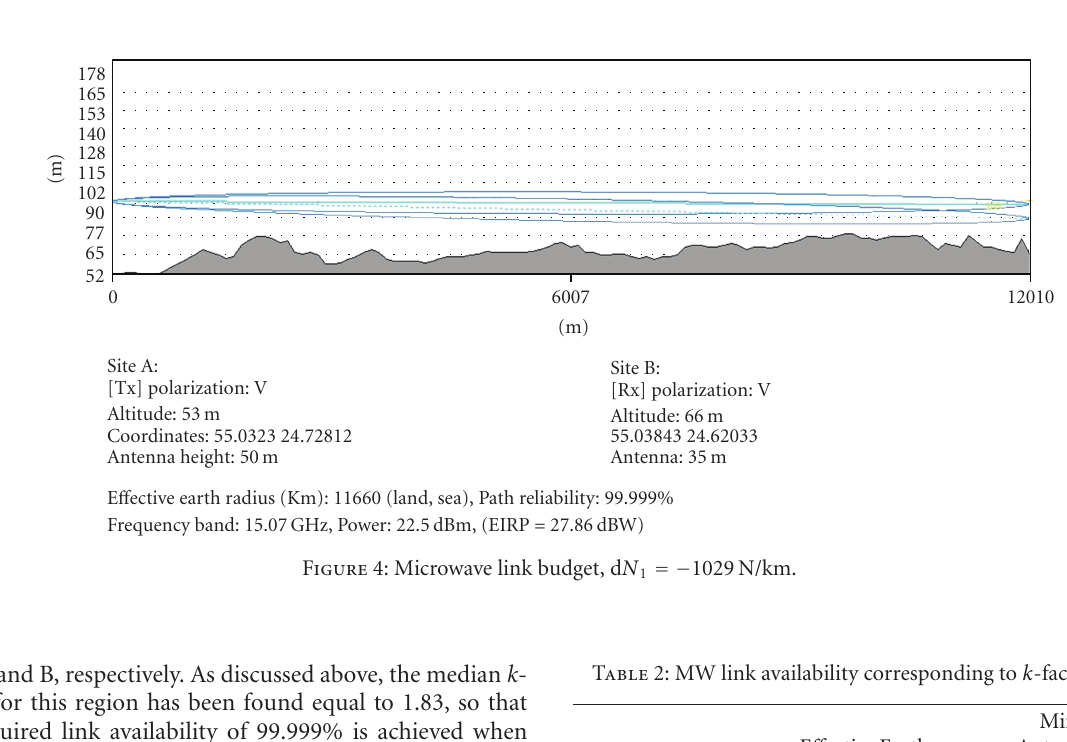
Figure 3: Microwave link budget, k = 1 . 83.